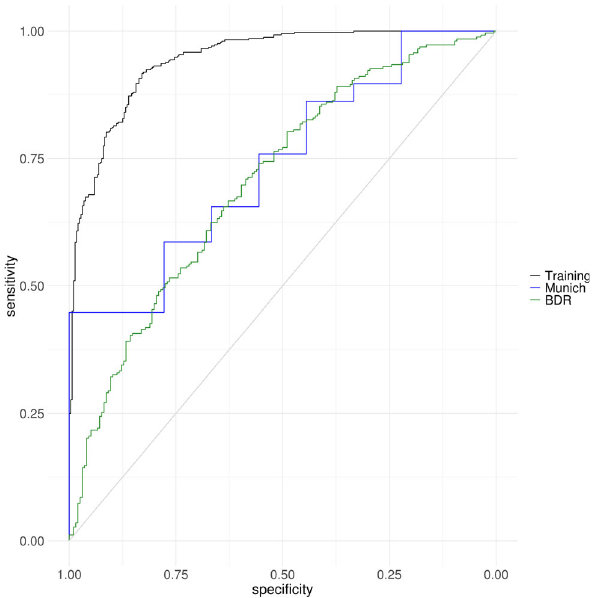
Fig. 4 Receiver operating characteristic (ROC) graphs highlighting the area under the curve (AUC) for the 110 cross-cortex probes that can best explain the variance in Braak pathology. An elastic net penalized regression model was used to identify a subset of 110 of the Bonferroni signi fi cant cross-cortex probes that could best predict whether a sample has low pathology (Braak 0 – II: control) compared to high pathology (Braak V – VI: AD) in a training dataset comprised of 996 discovery samples (Braak 0 – II: N = 407, Braak V – VI: N = 589). This model had an area under the ROC curve (AUC) of 94.33% (con fi dence interval [CI] = 92.88 – 95.64%) and explained 71.11% of the pathological variance (black line). The 110 probe signature was then tested in two independent replication cohorts. In